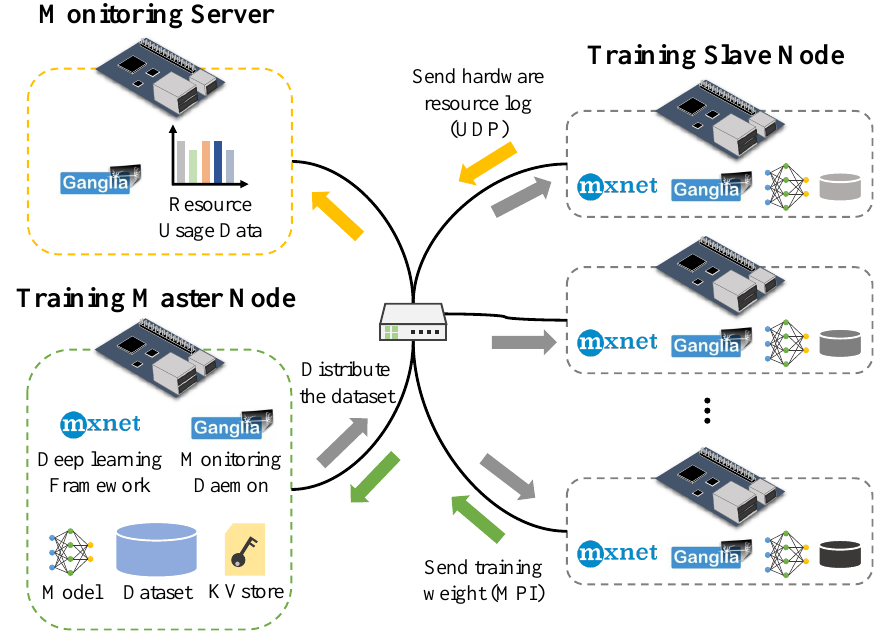
Figure 2. Distributed training